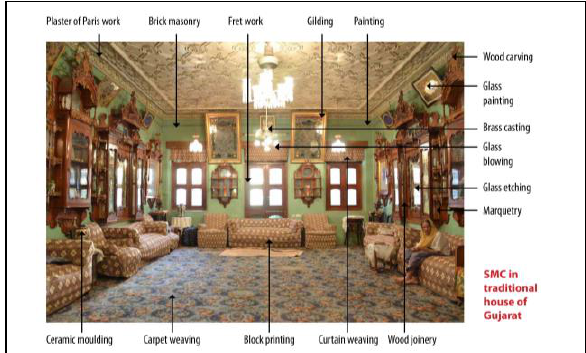
Figure 2. Space showing numerous craft techniques